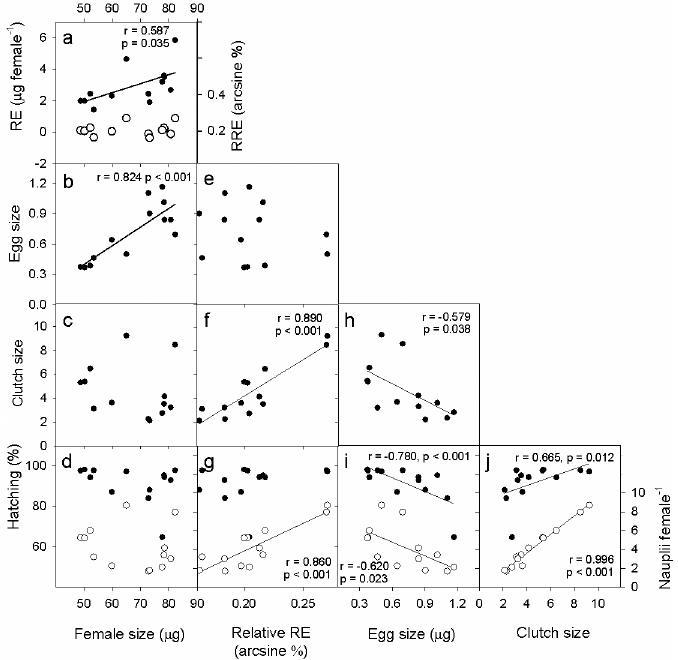
Fig 6. Relationships among the life-history traits of L . garciai in Lake Alchichica. Each point represents the population average at a given month. Probability and r coefficient values correspond to Pearson’s correlation tests; a significant negative correlation between two variables shows a potential functional trade-off. Open circles correspond to the left axis. RE, reproductive effort; RRE, relative reproductive effort (see text for further details).